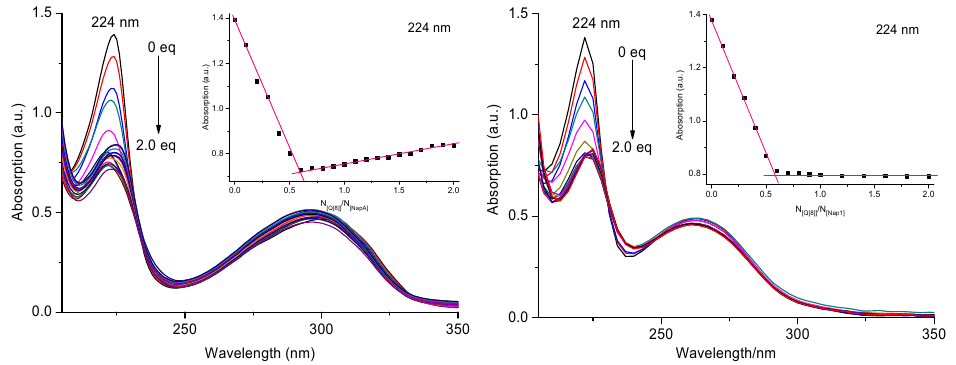
Figure 3. UV-vis spectra of NapA and Nap1 (10 μ M) with the addition of Q[8] (0–2.0 equiv.) in water at 25 °C (Inset: Absorbance at 224 nm vs. [Q[8]]/[ NapA ], and [Q[8]]/[ Nap1 ]).